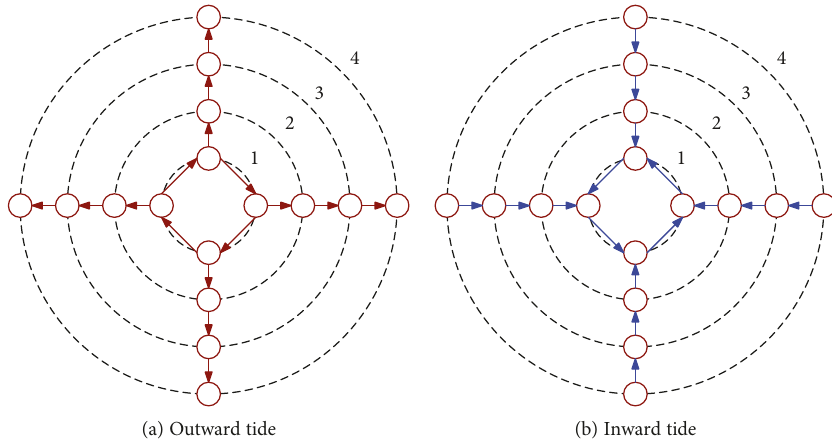
Figure 2: Migration scheme: forward (red) and backward (blue), for the 16-island case.